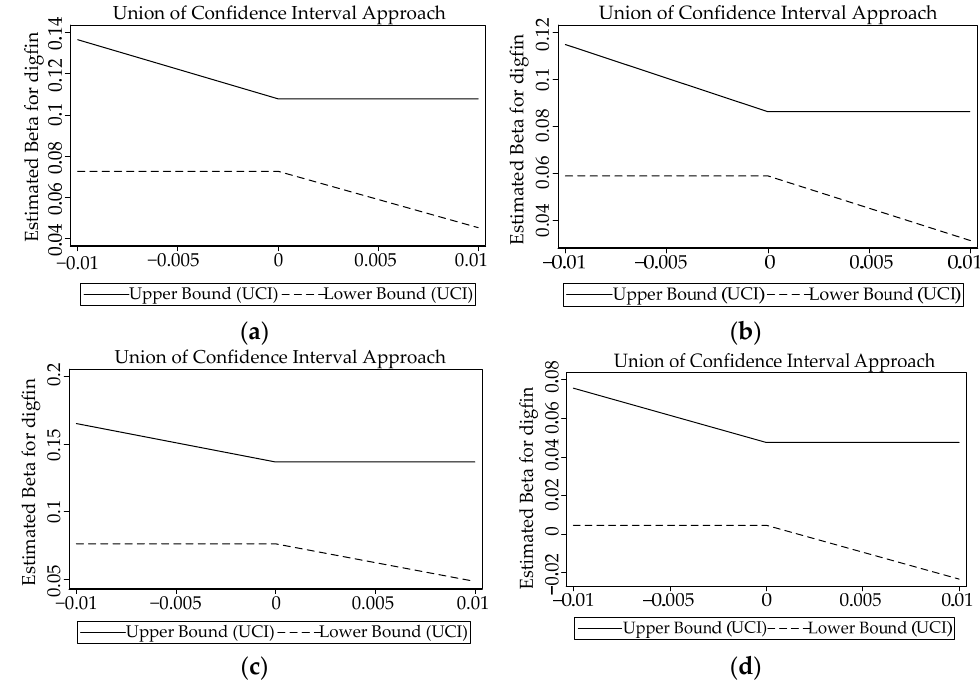
Figure 3. Confidence intervals based on the UCI method. ( a ) Financial availability; ( b ) investment availability; ( c ) bank loan availability; ( d ) private finance availability.